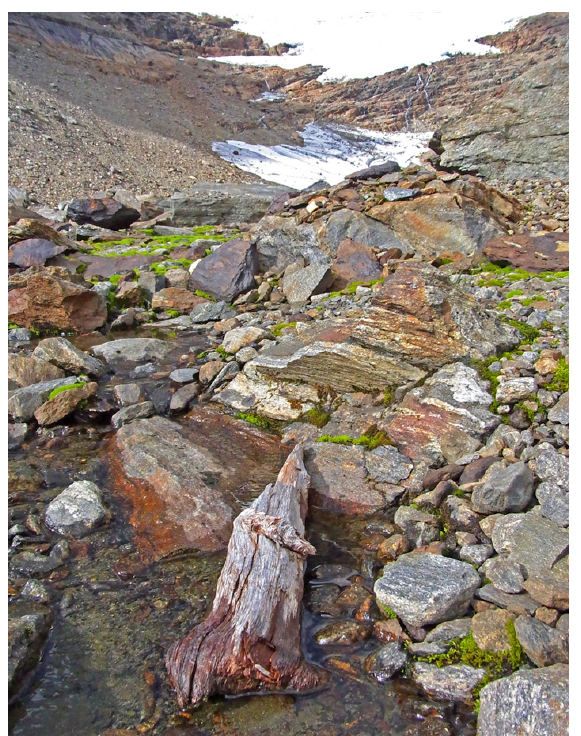
Figure 32: Tärnaglaciären (6). A large pine remnant recovered in the forefield, which has been deglacited during the past century. 9530 cal. yr BP (Beta-264394).